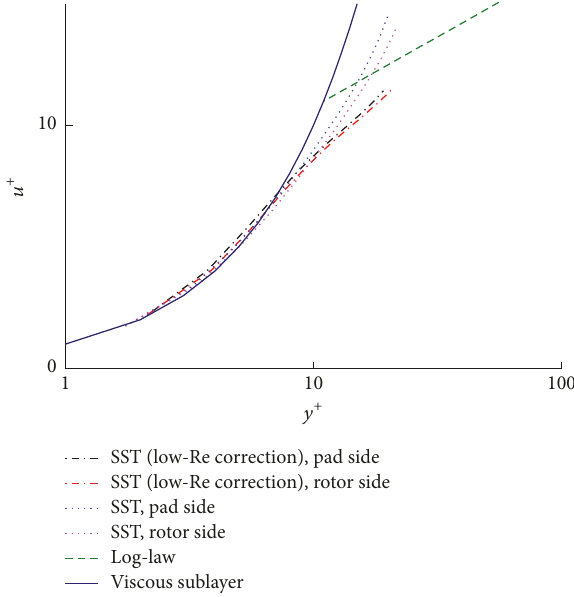
Figure 14: 𝑢 + and 𝑦 + in 40 ∘ from the